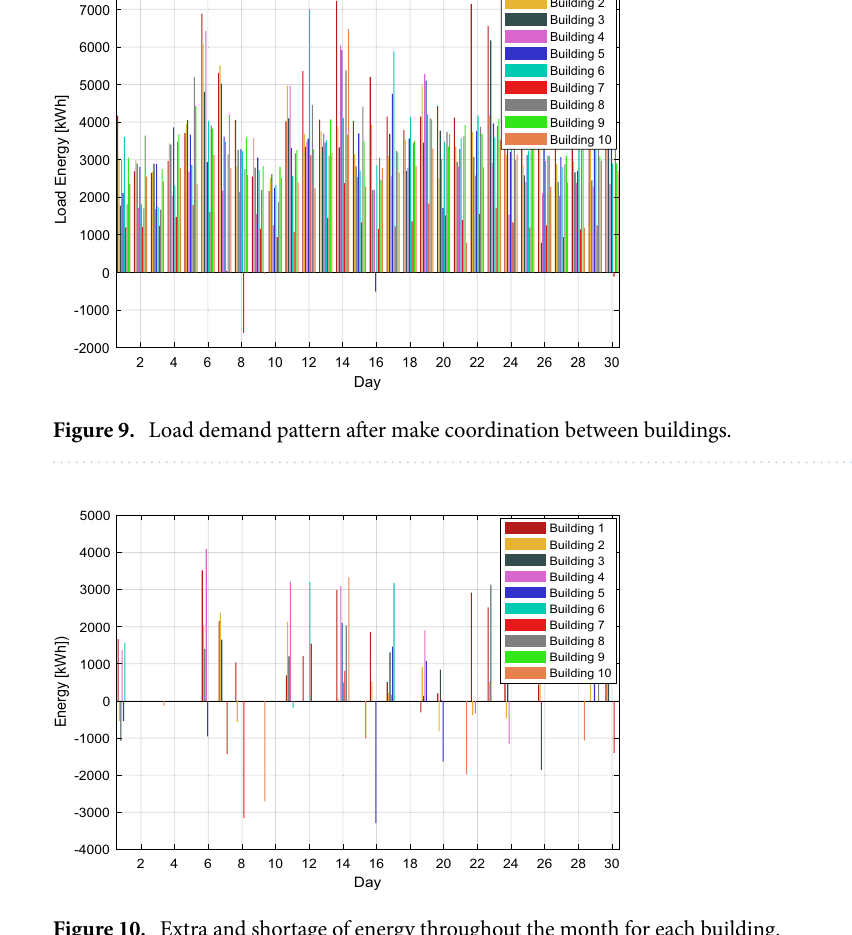
Figure 10. Extra and shortage of energy throughout the month for each